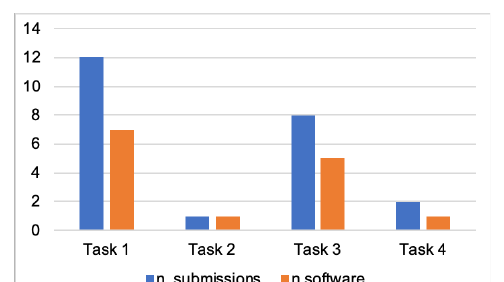
Figure 5. Comparison between number of tests and tested software per task.